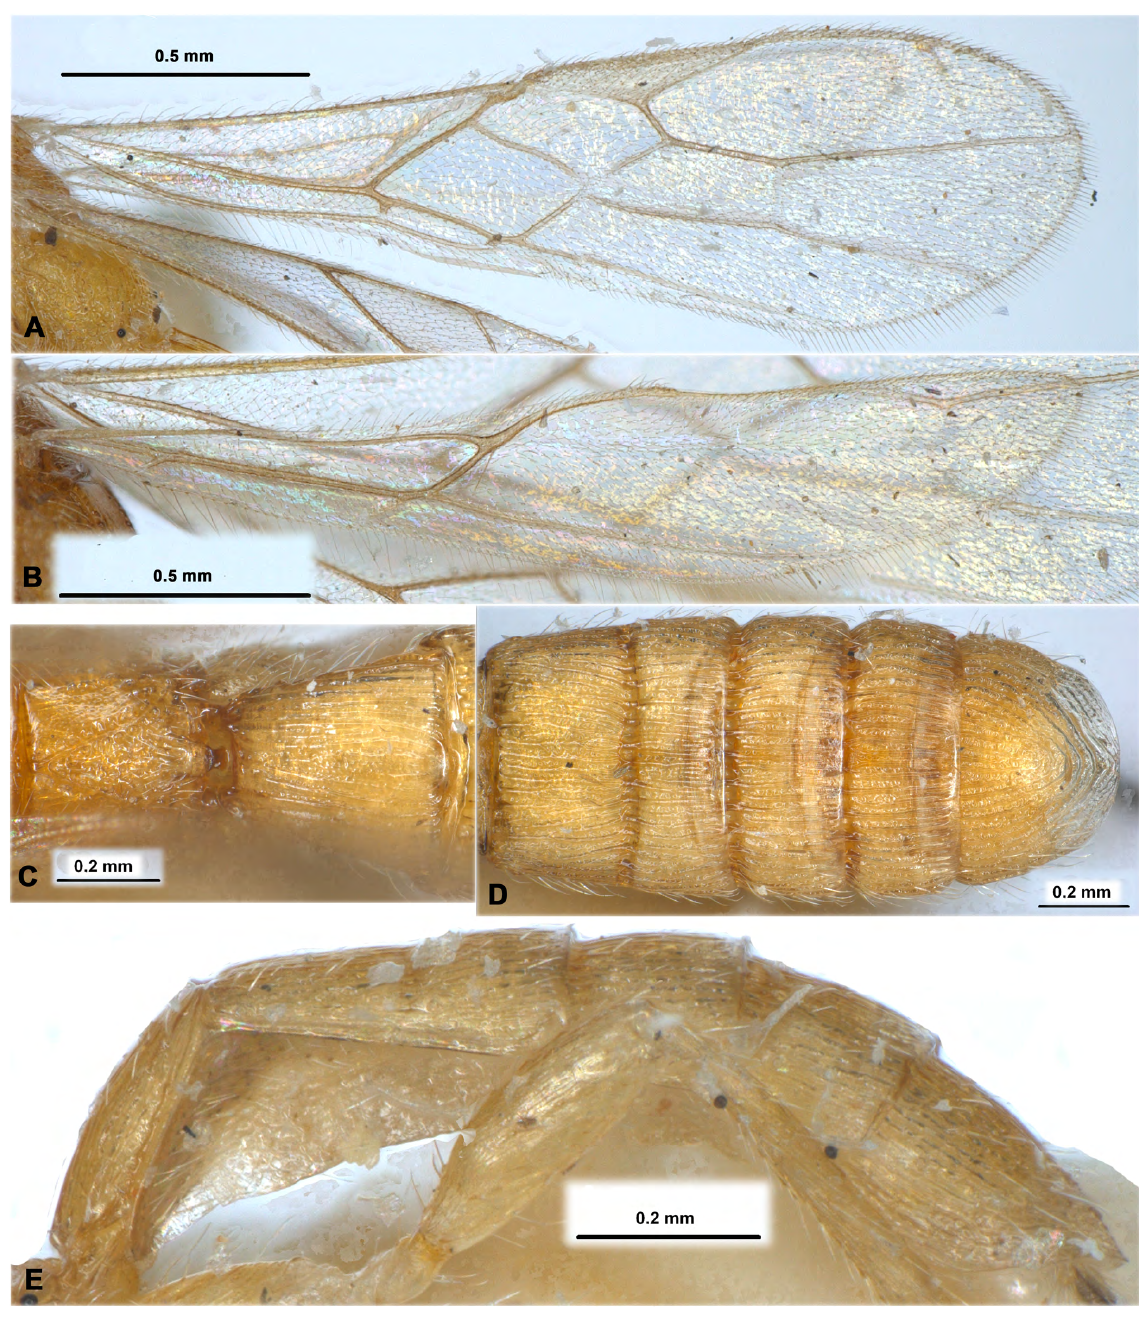
Fig. 43. Rhaconotinus ( Hexarhaconotinus ) hexatermus (Belokobylskij, 1988) comb. nov., ♀, holotype, ZISP. A . Fore wing. B . Hind wing. C . Propodeum and first metasomal tergite, dorsal view. D . Metasoma without first tergite, dorsal view. E . Metasoma, lateral